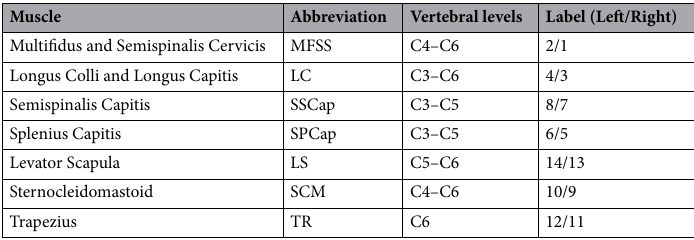
Table 1. Muscle abbreviations.